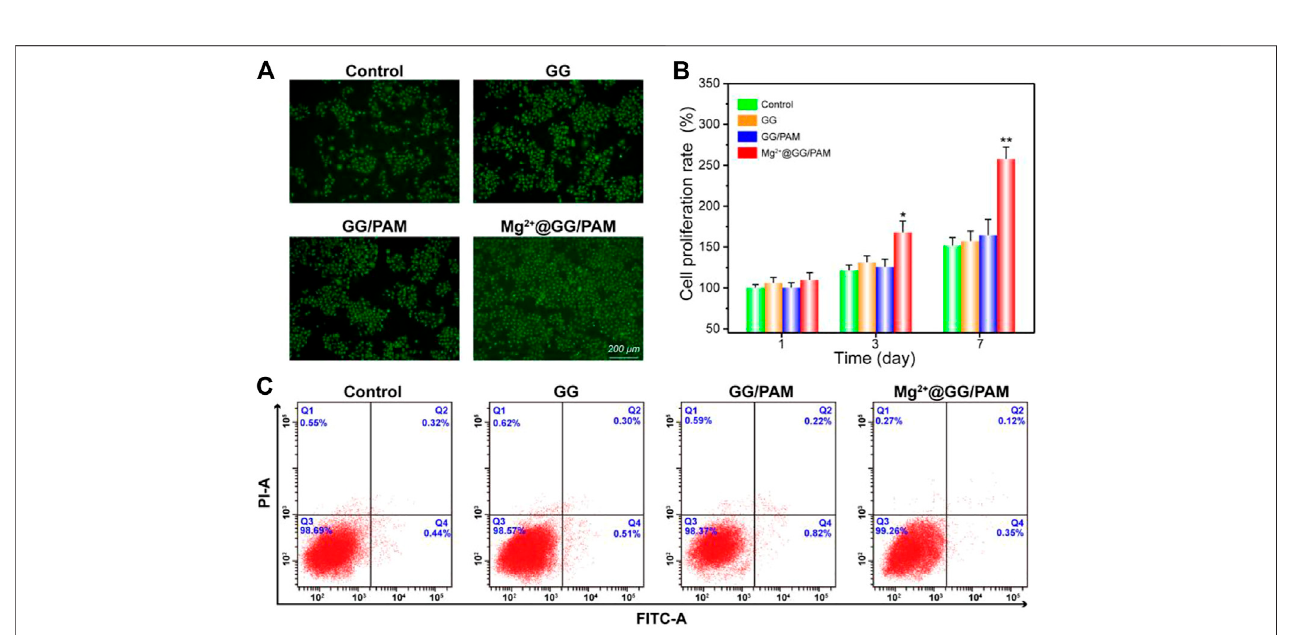
Frontiers in Bioengineering and Biotechnology |